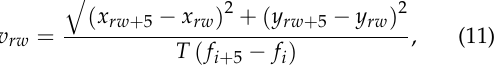
Table 3. Selection of trunk inclination